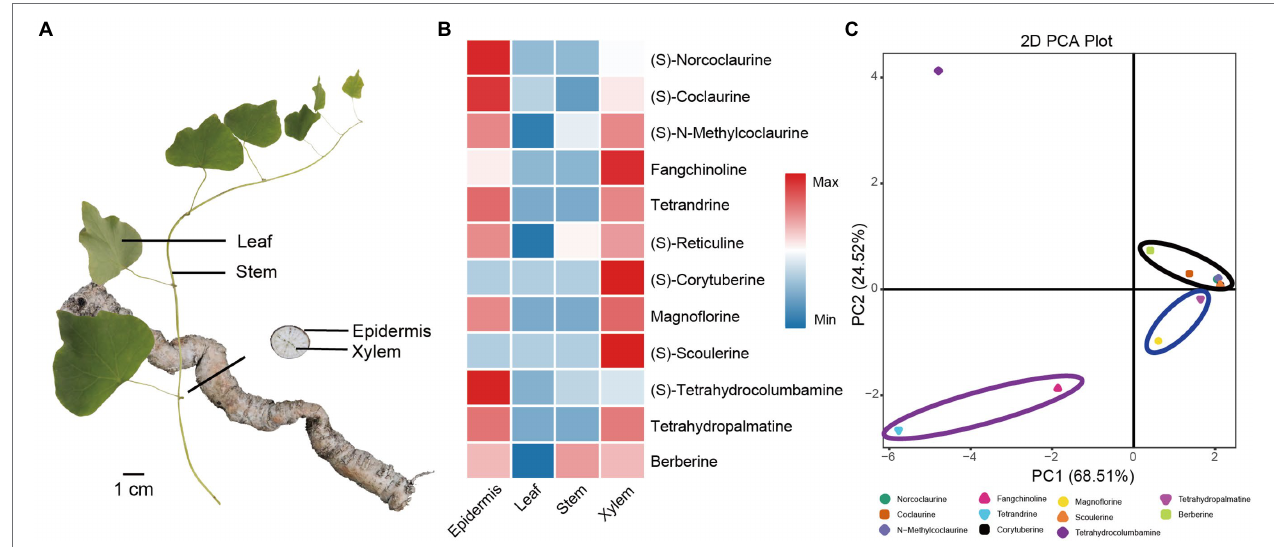
FIGURE 1 | Quantitative analysis and PCA analysis of 12 BIAs in the stem, leaf, xylem, and epidermis of Stephania tetrandra . (A) Four tissues (stem, leaf, xylem, and epidermis) of S. tetrandra used for transcriptome sequencing and determination BIAs concentration. (B) Heat map of the relative content of 12 BIAs in each tissues. (C) PCA score plot of 12 BIAs.